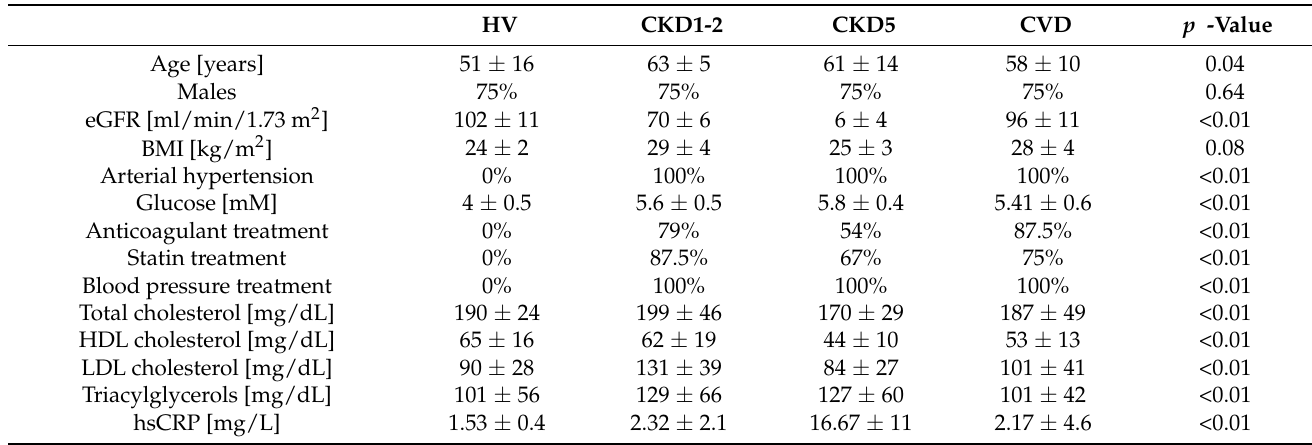
Table 1. Demographic data and clinical characteristics of the study. Mean value ± SD. p < 0.05 was considered to be statistically significant. eGFR—estimated glomerular filtration rate, BMI—body mass index, hsCRP—high-sensitivity C-reactive protein. Chi- square test was used for categorical variables, while for other variables, Mann–Whitney U-test was